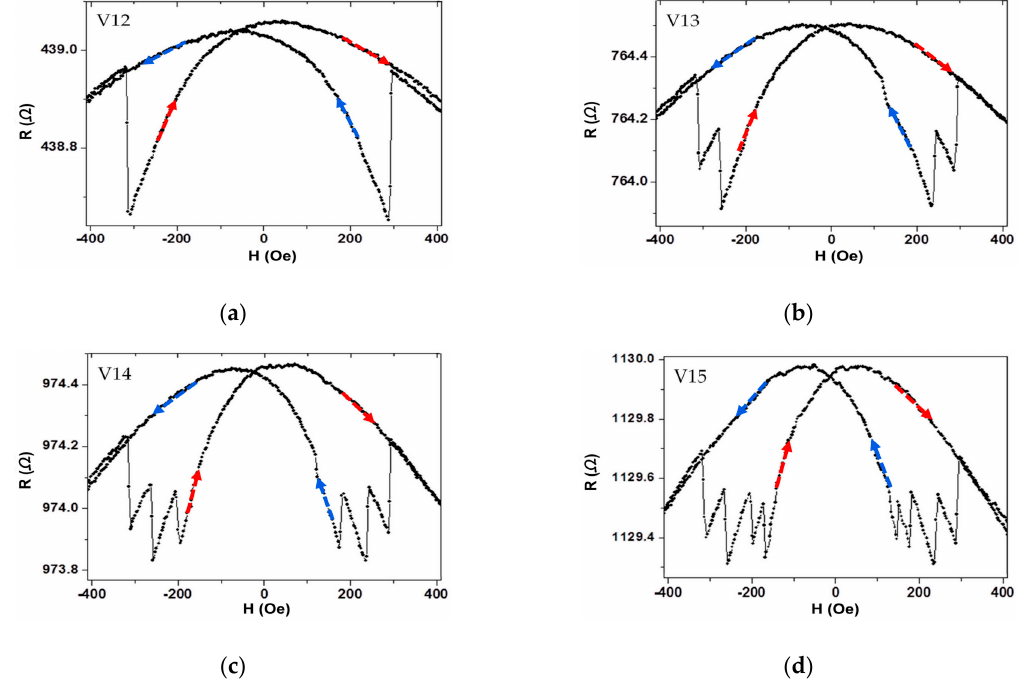
Figure 3. Room temperature MR loops: longitudinal MR of middle-contact half-ring wire with ( a ) voltage contact V1 and V2; ( b ) voltage contact V1 and V3; ( c ) voltage contact V1 and V4; ( d ) voltage contact V1 and V5. The arrows indicate the direction of the proceeding process on the loop.